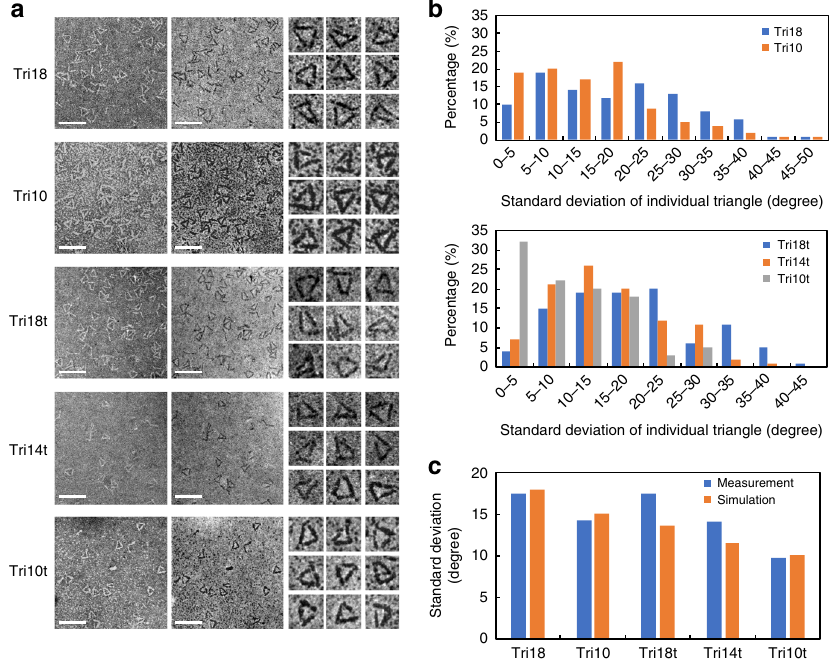
Fig. 2 Construction of protein triangles and optimization of vertex linker lengths. a STEM images of protein triangles. The images in the left column are bright- fi eld overview images of the triangles, the images in the middle column are dark- fi eld overview images of the same triangles, and the images in the right column are magni fi ed dark- fi eld images of individual triangles. Scale bars, 50 nm. Magni fi ed images, 25 nm × 25 nm. b Histograms displaying the standard deviations of the three vertex angles within each individual triangle for the fi ve triangular nanostructures made in this study using full length (above) and truncated (below) 3HB constructs ( n = 100 triangles for each structure). c Standard deviations of all individual vertex angles in each of the fi ve constructed triangles from STEM image measurements and computational simulations ( n = 100 triangles for each structure). Source data are provided as a Source Data fi